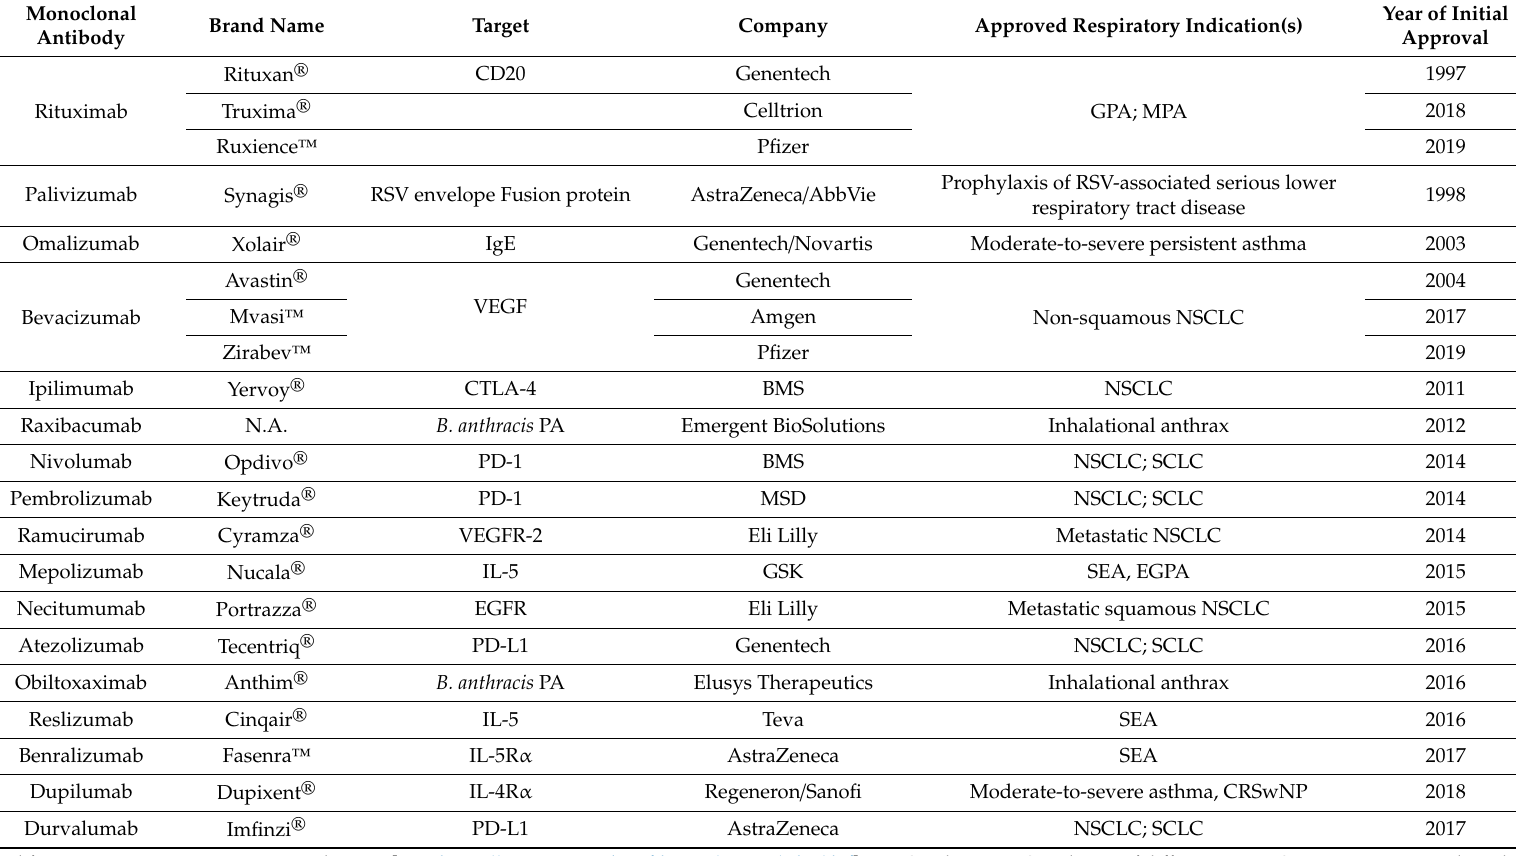
Table 1. Monoclonal antibodies approved by the FDA for the treatment of respiratory